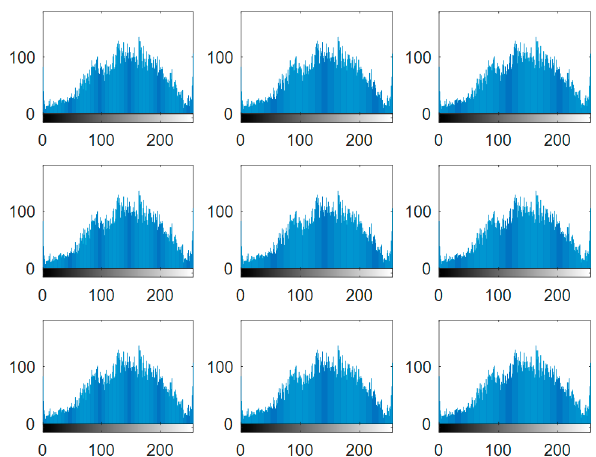
Figure 23. Histograms of the sample facial images in Figure 14.